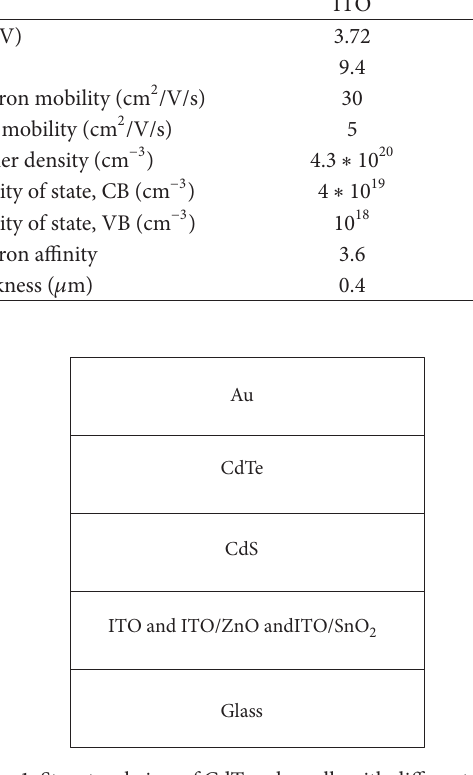
F 1: Structural view of CdTe solar cells with different con�gu-